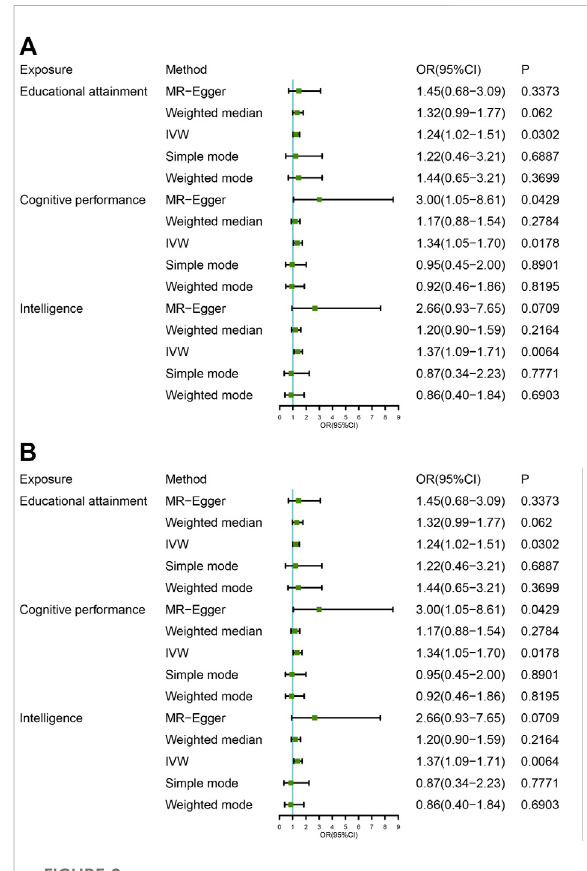
FIGURE 2 Mendelianrandomizationanalysisoftheassociationbetween intelligence educational attainment, cognitive performance, and Parkinson disease. OR, odds ratio; CI, con fi dential interval. (A) Parkinson GWAS data for outcomes (no gender difference); (B)